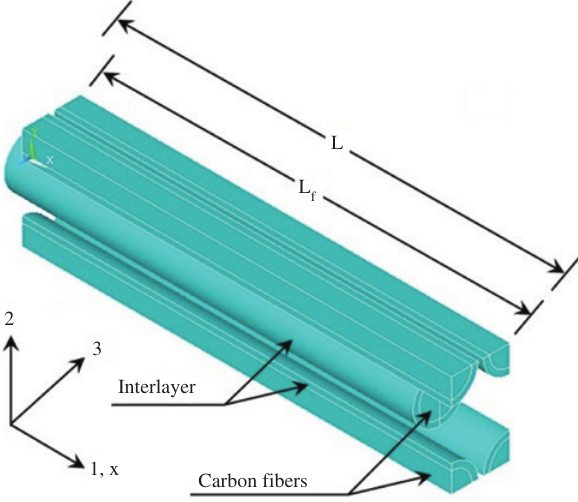
Figure 6: Analytical shear lag model validation by comparison to FE shear lag model for the axial stress in the carbon fiber along its length.